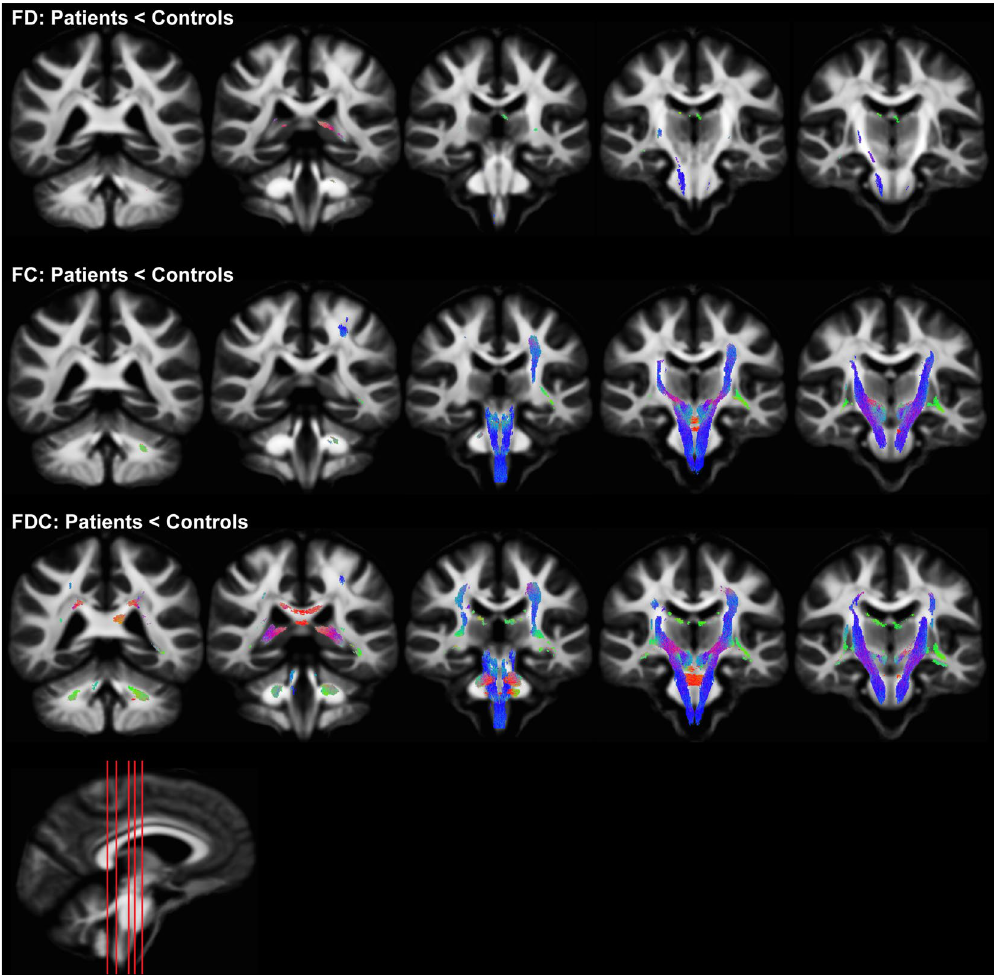
Figure 2. Fixel-based analysis showing significantly reduced fiber density (FD), fiber bundle cross-section (FC) and fiber density and cross-section (FDC) in patients with HD. Reduction in FD was limited to the corticospinal tract while FC and FDC were significantly reduced in the corticospinal tract, cerebellar peduncles, pontine crossing tracts, internal and external capsules, medial lemniscus, cerebral peduncles, sagittal stratum, and corona radiata. FDC was also reduced in the fornix/stria terminalis and the corpus callosum in patients with HD. Significantly reduced streamlines are directionally colored (red: left–right, green: anterior–posterior, blue: